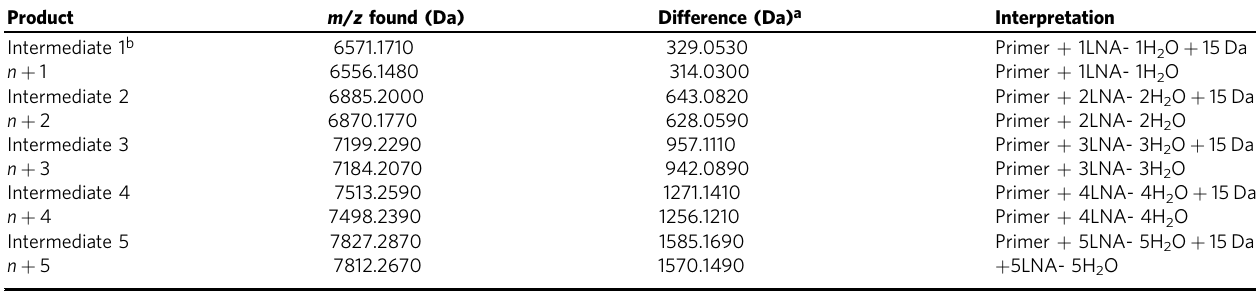
Table 3 LCMS analysis of reaction products obtained with the TdT, 5 ′ -FAM-labeled primer P2, Co 2 + , and 3 h of reaction at 37 °C. Product m / z found (Da) Difference (Da) a Interpretation Intermediate 1